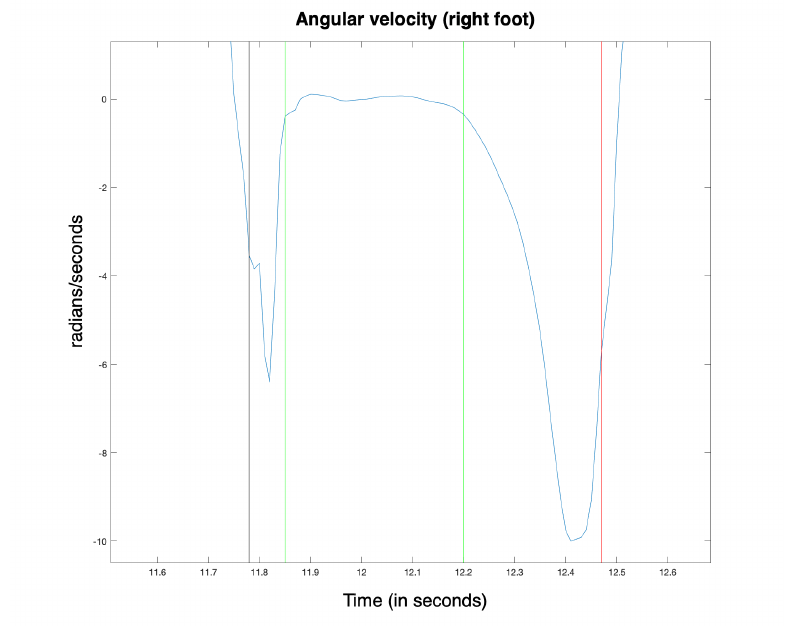
Figure 4. XSens Sensor, with axes orientations.